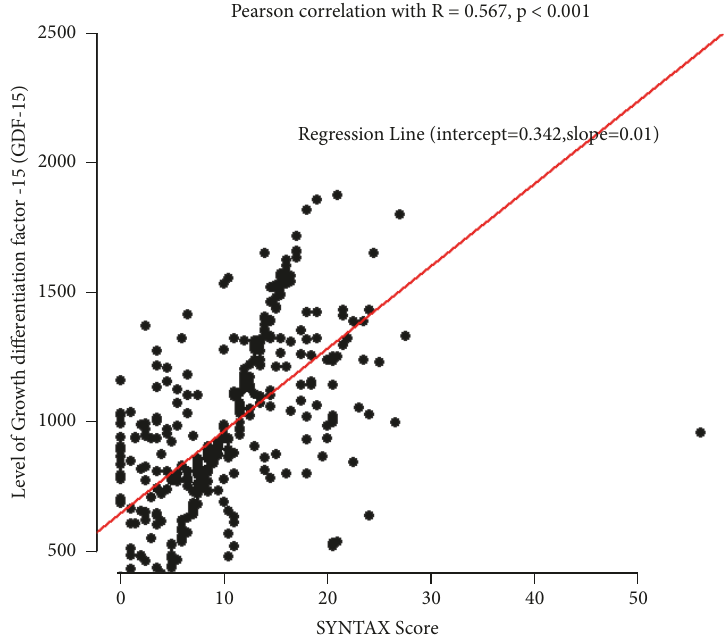
Figure 1: Correlation between GDF-15 levels and Syntax